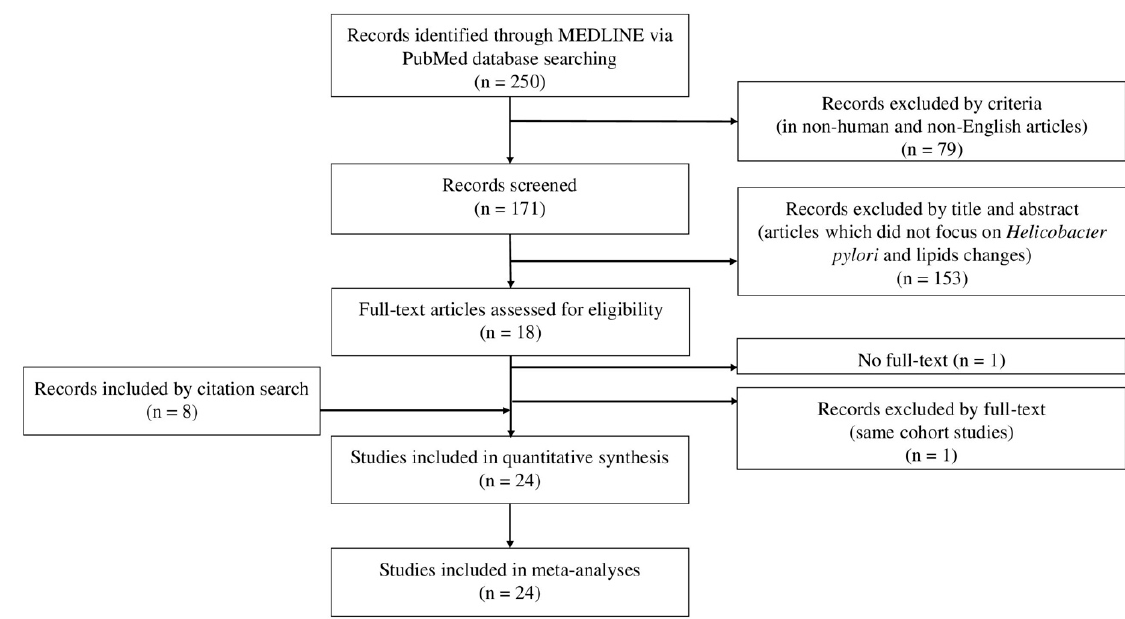
Figure 1. Flow chart of article selection.